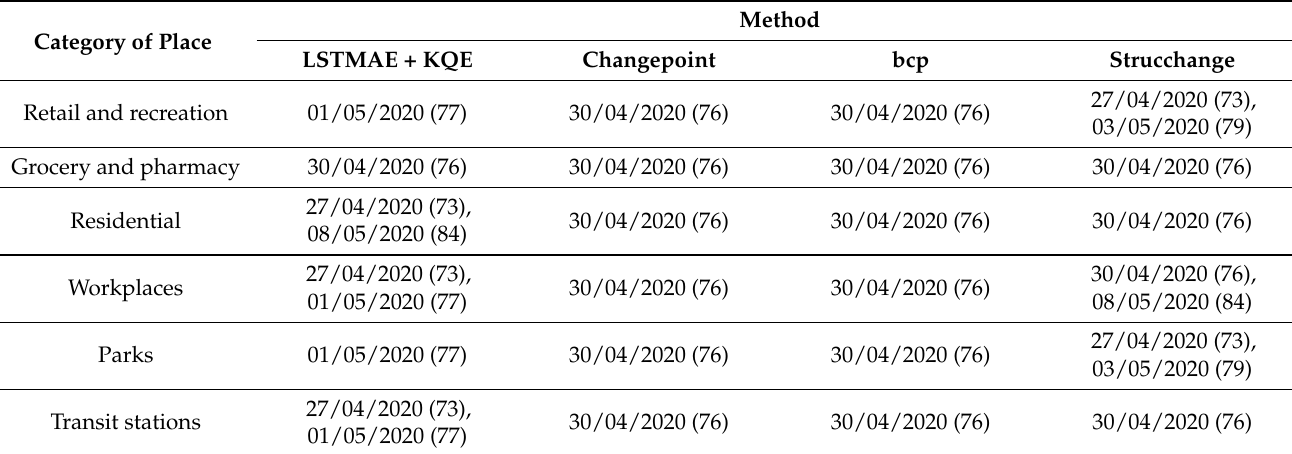
Table 2. A comparison of the date of occurrence and location of the change-points that were detected by the